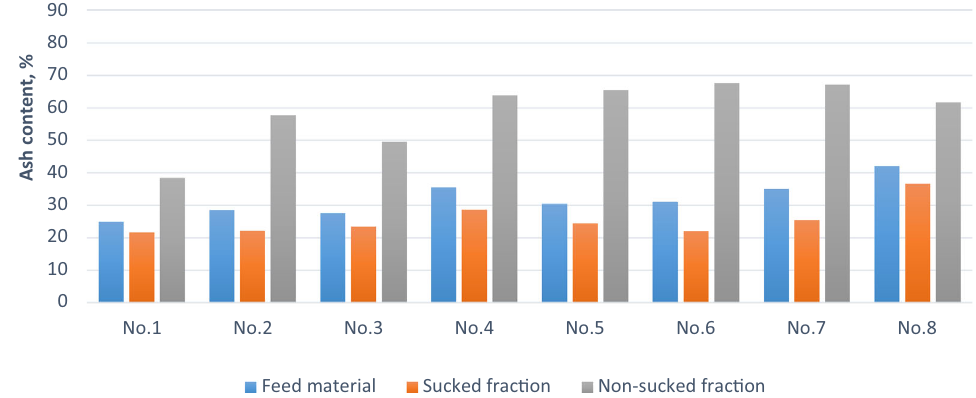
Fig. 14 Ash content with respect to the origin of the feed material (grain-size class of 0–20 mm)